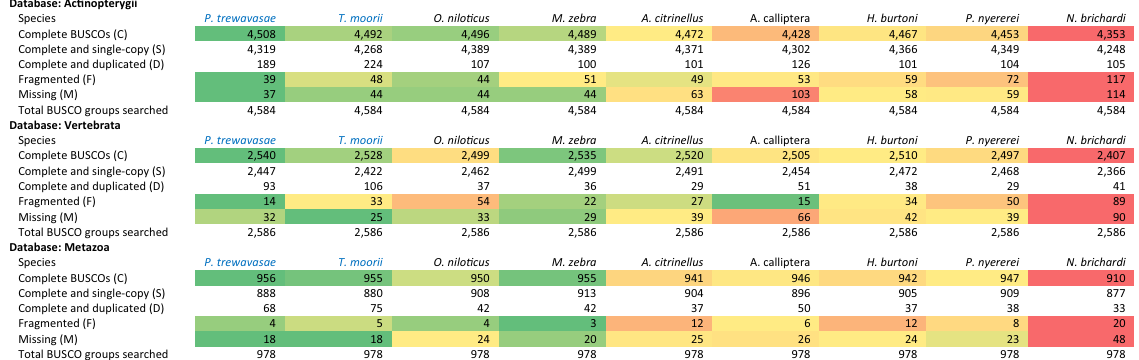
Table 5. BUSCO results: Identified genes are classified as ‘complete’ when their lengths are within two standard deviations of the BUSCO group mean length (i.e., within ∼ 95% expectation). ‘Complete’ genes found with more than one copy are classified as ‘duplicated’; BUSCOs are expected to evolve under single-copy control, hence recovery of many duplicates may indicate erroneous assembly of haplotypes. Genes only partially recovered are classified as ‘fragmented’, and genes not recovered are classified as ‘missing’ 34 . The latest versions of assemblies were used in all cases (i.e., V4 of O. niloticus and M. zebra ). See BUSCO results for PT and TM transcriptome assemblies in Supplementary Table S5. Values are color coded according to the rank: Dark green, best; dark red, worst. BUSCO stands for benchmarking universal single-copy ortholog.